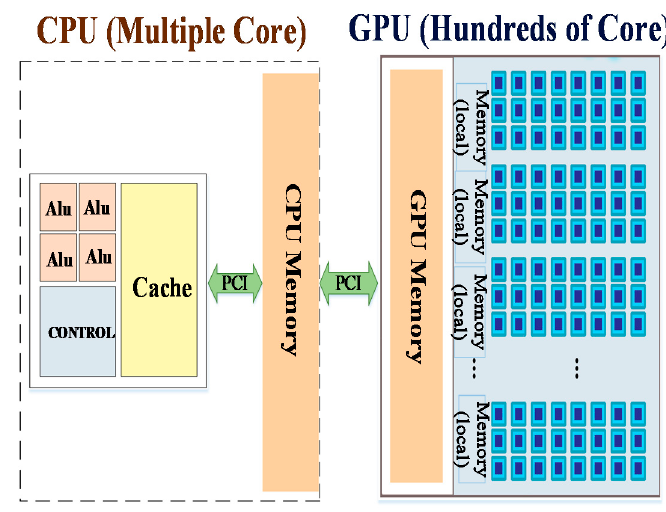
Figure 1. CPU and graphics processing unit (GPU) architectures.